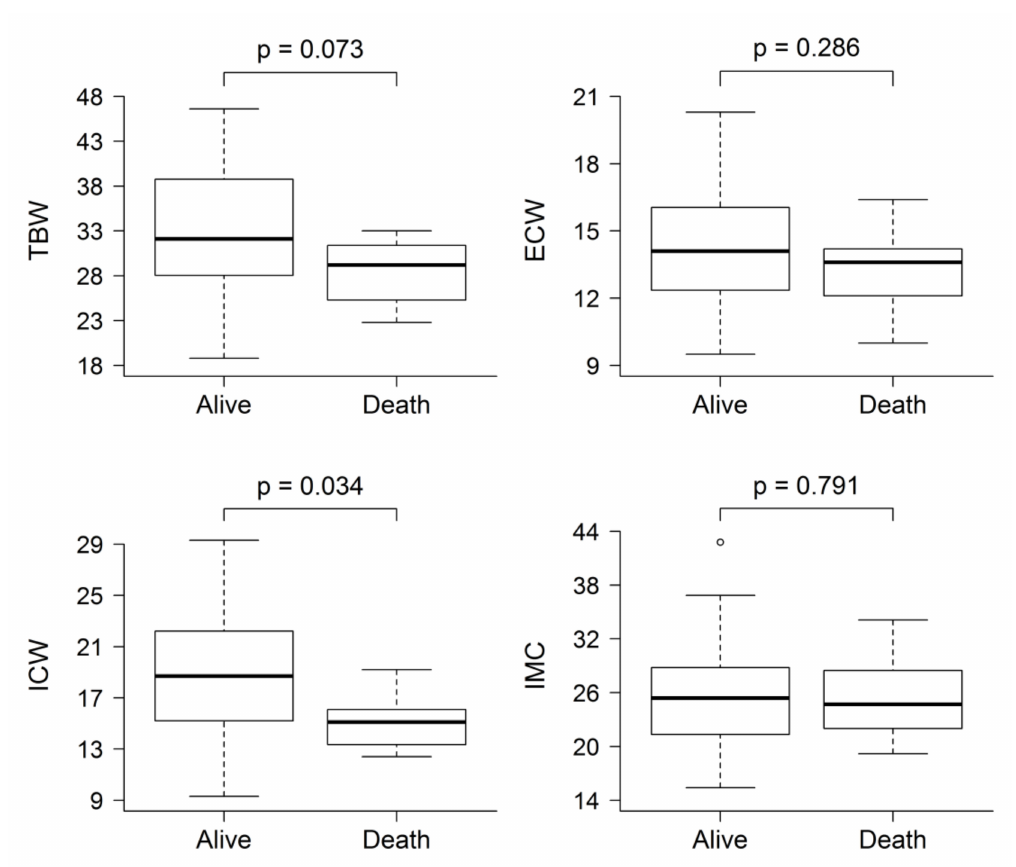
Figure 2. Comparison of baseline post-dialysis fluid status composition between patients who were dead and alive at last follow-up. The only body fluid parameter that was statistically significantly di ff erent was ICW.